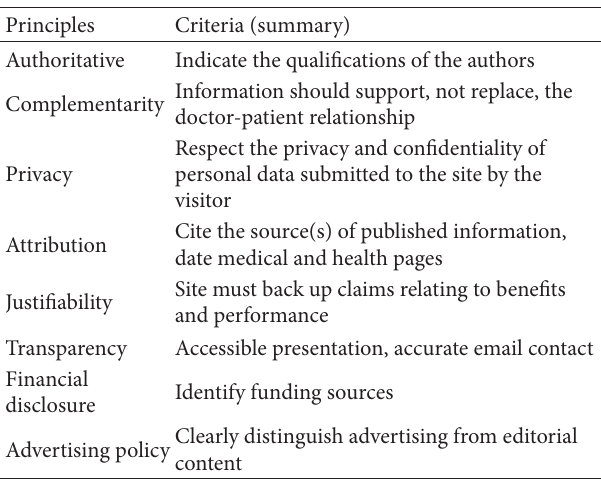
Table 1: Principles of the HON